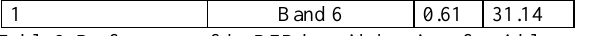
Table 2. Performance of the RFR by withdrawing of variables.